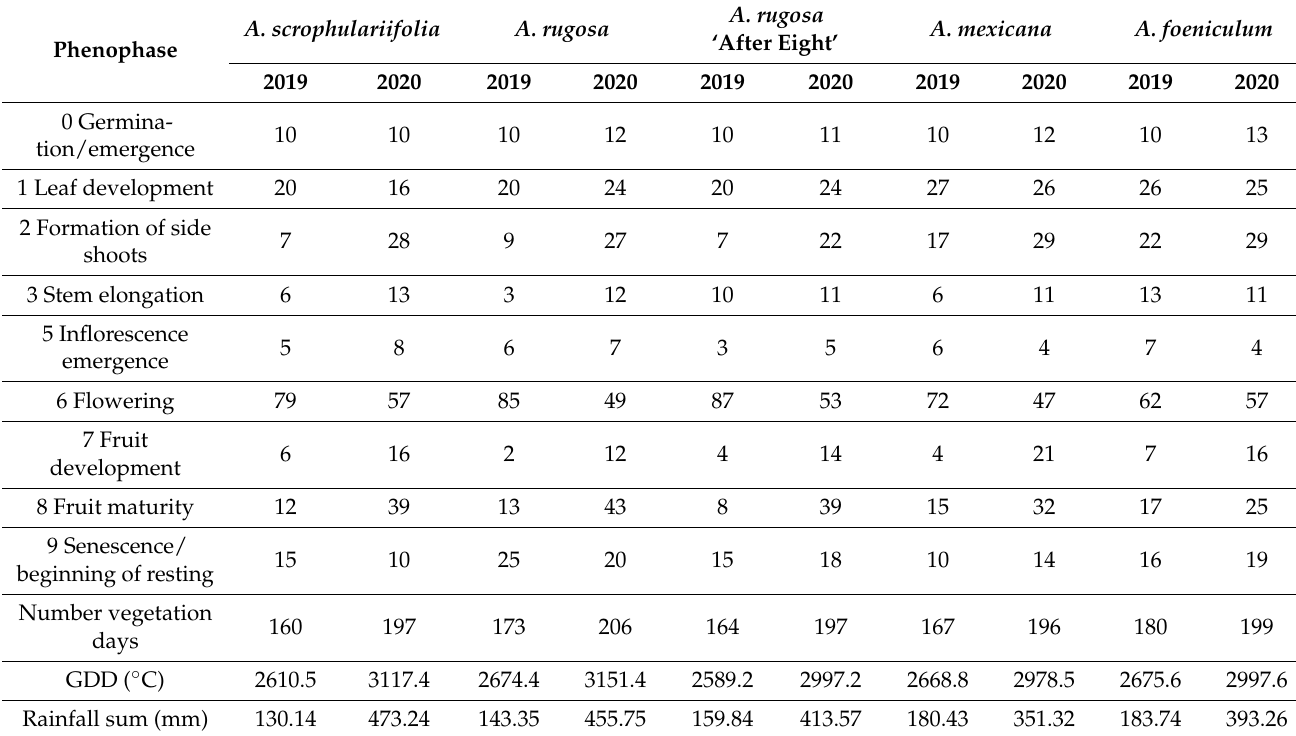
Table 5. Duration (number of days) of growth stages of Agastache in Cluj-Napoca conditions.